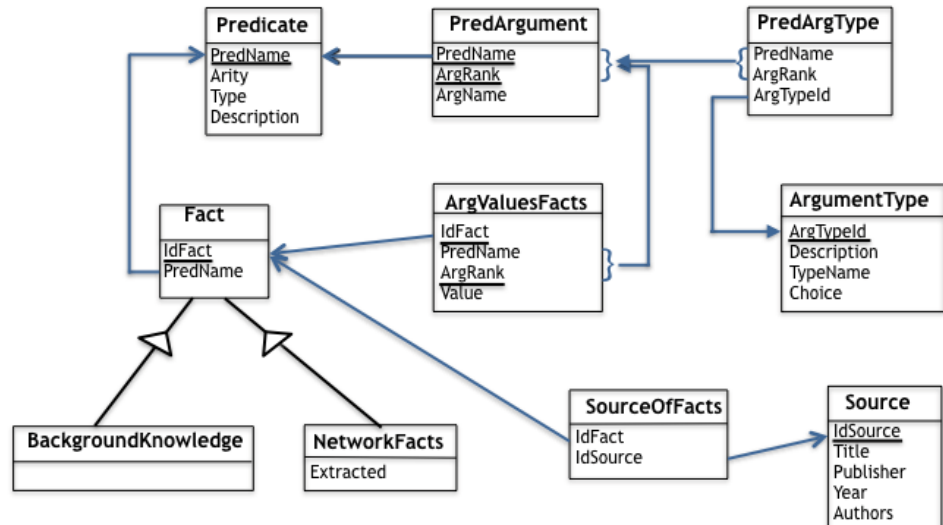
Figure 13. Graphical representation of relational